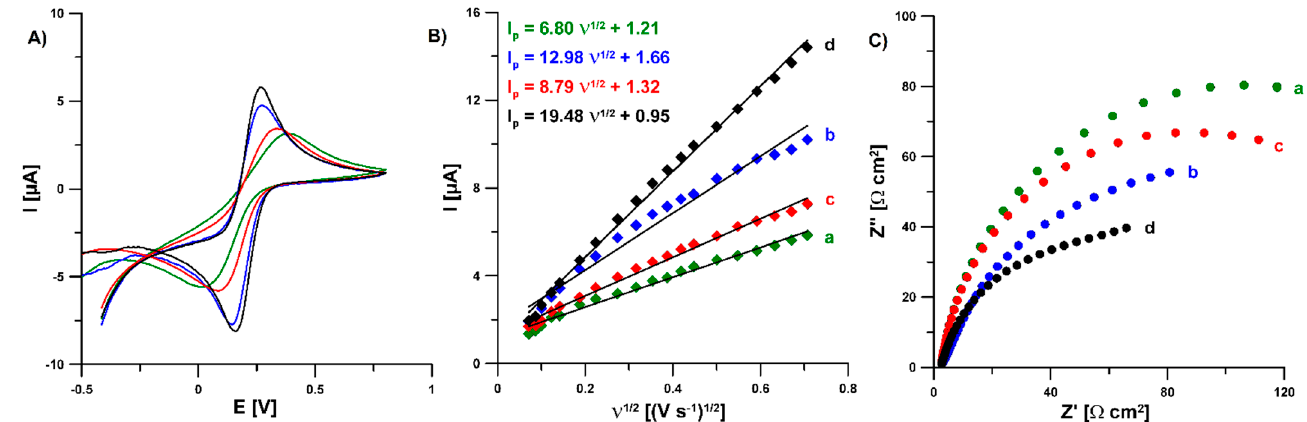
Figure 8. ( A ) CVs recorded in 0.1 M KCl containing 5.0 mM K 3 [Fe(CN) 6 ] at the bare GCE (green curve), PbF/GCE (red